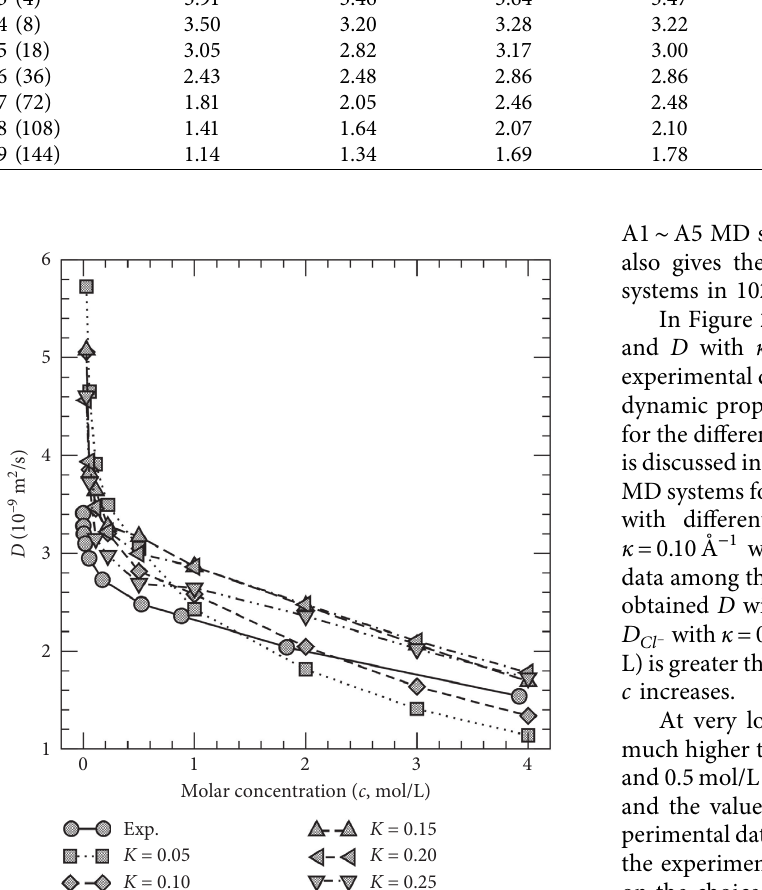
Figure 1: Comparison of the diffusion coefficients ( D � D D Cl − ) of NaCl at 25 ° C as a function of the molar concentration (c) of NaCl for given Ewald sum parameters ( κ ) employing a velocity Verlet algorithm obtained from MSDs of our MD simulations with the experimental data